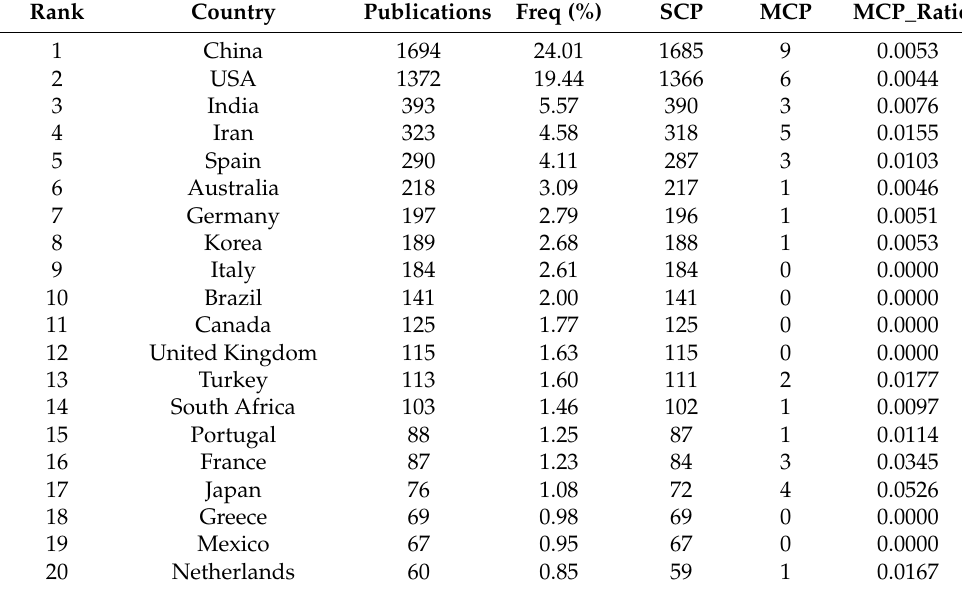
Table 1. Top publications per country based on the corresponding author’s countries in DI